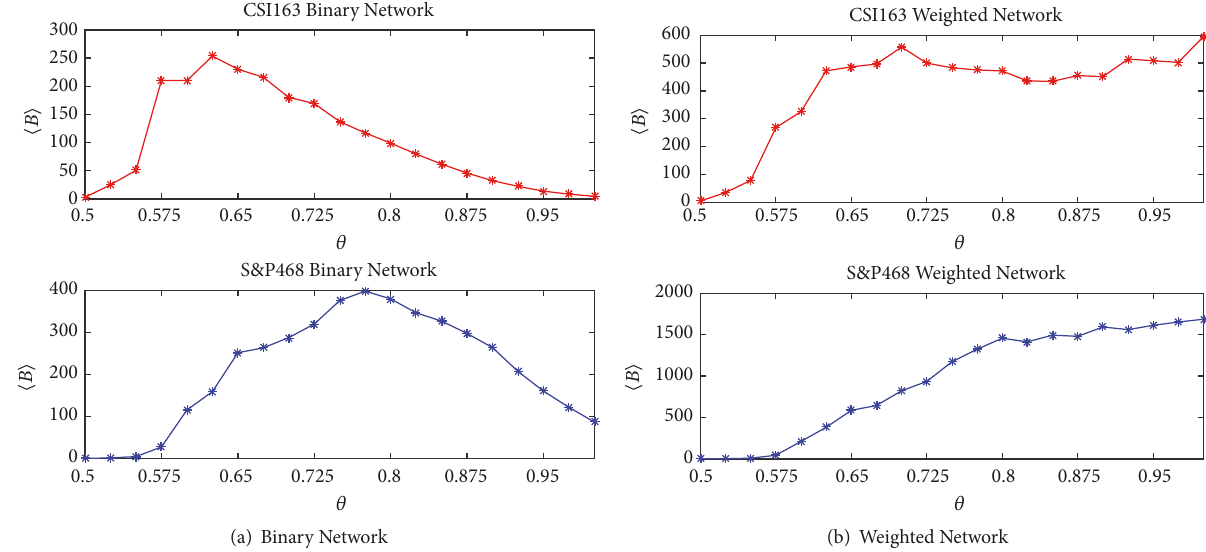
Figure 6: Average betweenness ⟨𝐵⟩ of CSI163 and S&P468 is calculated for both the original weighted approach and binary simplification approach under different 𝜃 . The average betweenness for binary networks is different from the weighted network. For binary networks, the curvesfor CSI163 and S&P468 share a similar shape.On the left hand of the peak, the ⟨𝐵⟩ gets larger with the increaseof 𝜃 , for more edges and moreverticesarepreserved,andthisleadstoagrowingnumberofpaths,whileontherighthandofthepeak,largeconnectednetworkemerges leading to a small value of averaged ⟨𝐵⟩ . In other words, the importance of a single individual vertex or edge is weakened in well-connected networks (large 𝜃